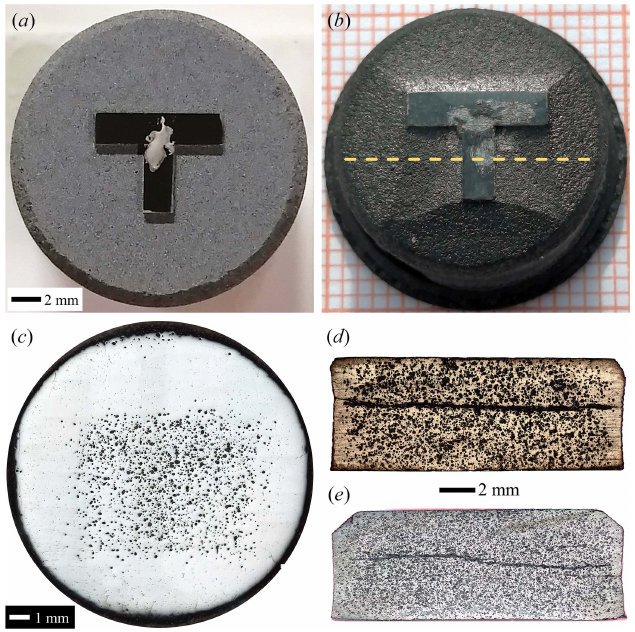
Figure 7 Photographs of YBCO samples by vertically connected seeding, T-type for ( a )–( d ) and Z-type for ( e ). Top views of ( a ) the initial precursor pellet with a T-seed and ( b ) the as-grown crystal after splitting off the T-seed. Polished samples under an optical microscope: ( c ) top view and ( d ) and ( e ) cross-sections. The scale bar is the same for ( d ) and ( e